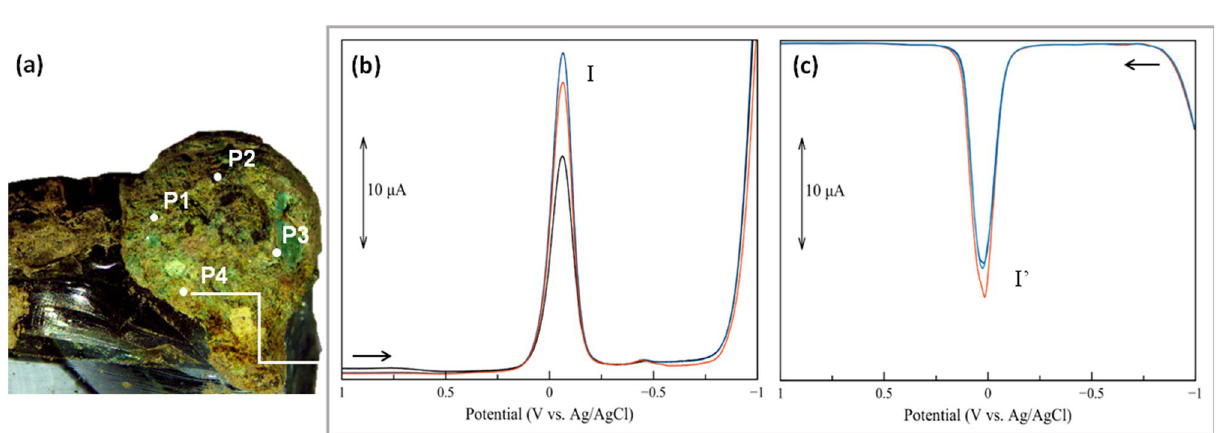
Figure 4. Distribution of the sampling points on the surface of inclusion #1 investigated by VIMP and FESEM- EDS ( a ). Overlap of cathodic ( b ) and anodic ( c ) voltammograms of microparticles (triplicate measurements) collected in P4. (Image: Francesca Di Turo, Giulia